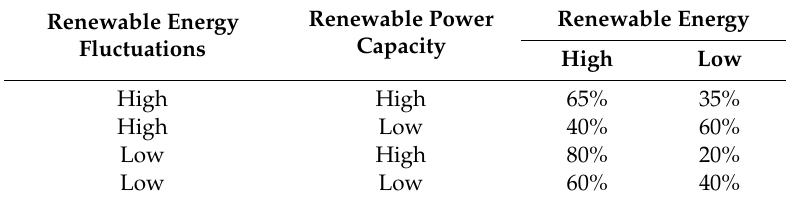
Table 5. The probability distribution of transition state in the first stage of decision making.